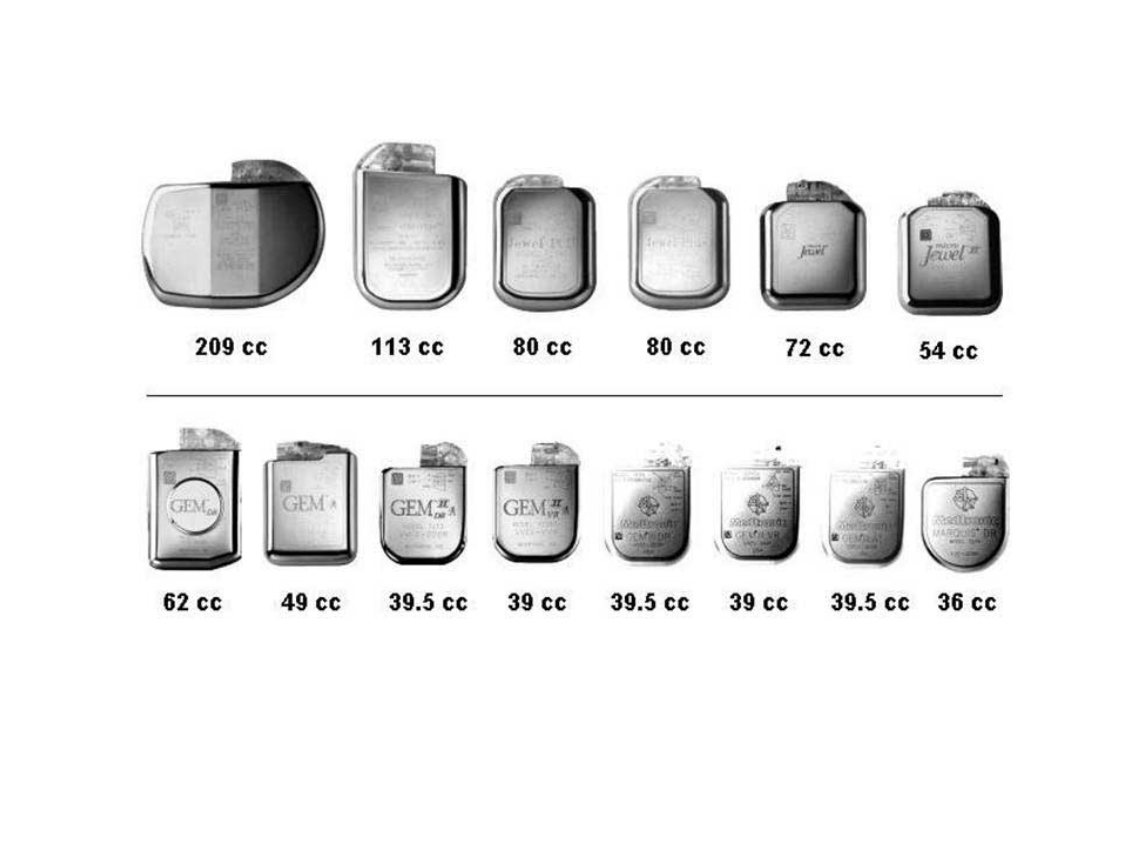
Reduction in the size of ICDs from 1989 to 2003. Source: